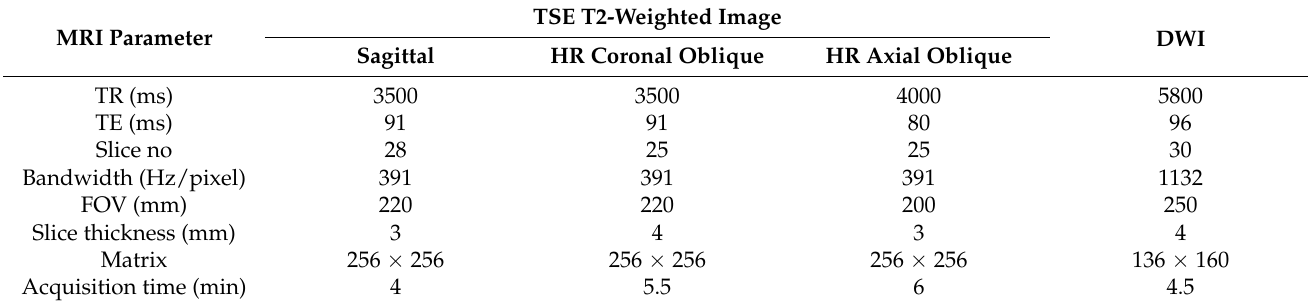
Table 1. MRI parameters.